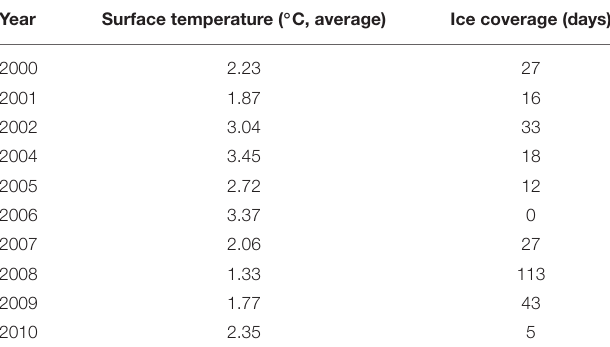
TABLE 2 | Days of ice coverage over the sediment trap at the “Central Hausgarten Station” during the summer of the collection period and the average surface temperature in the “Hausgarten” during summer in the year of the collection period.